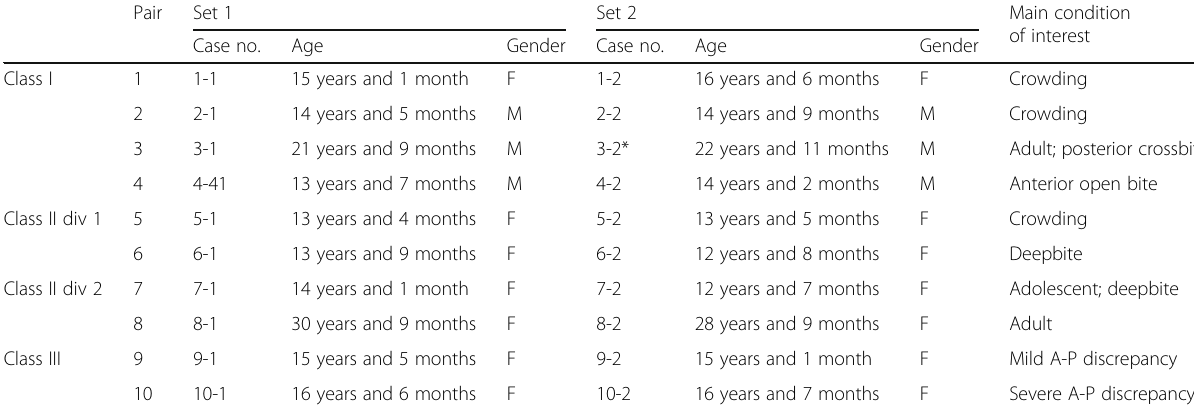
Table 2 Summary of patient characteristics